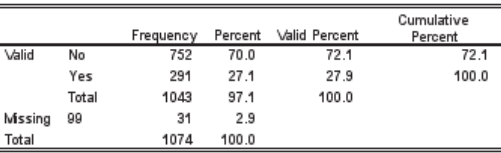
<Table 8> Percentage of K-Pop Artists Information/ Videos/Images/news Sharing by Fans of Social Media